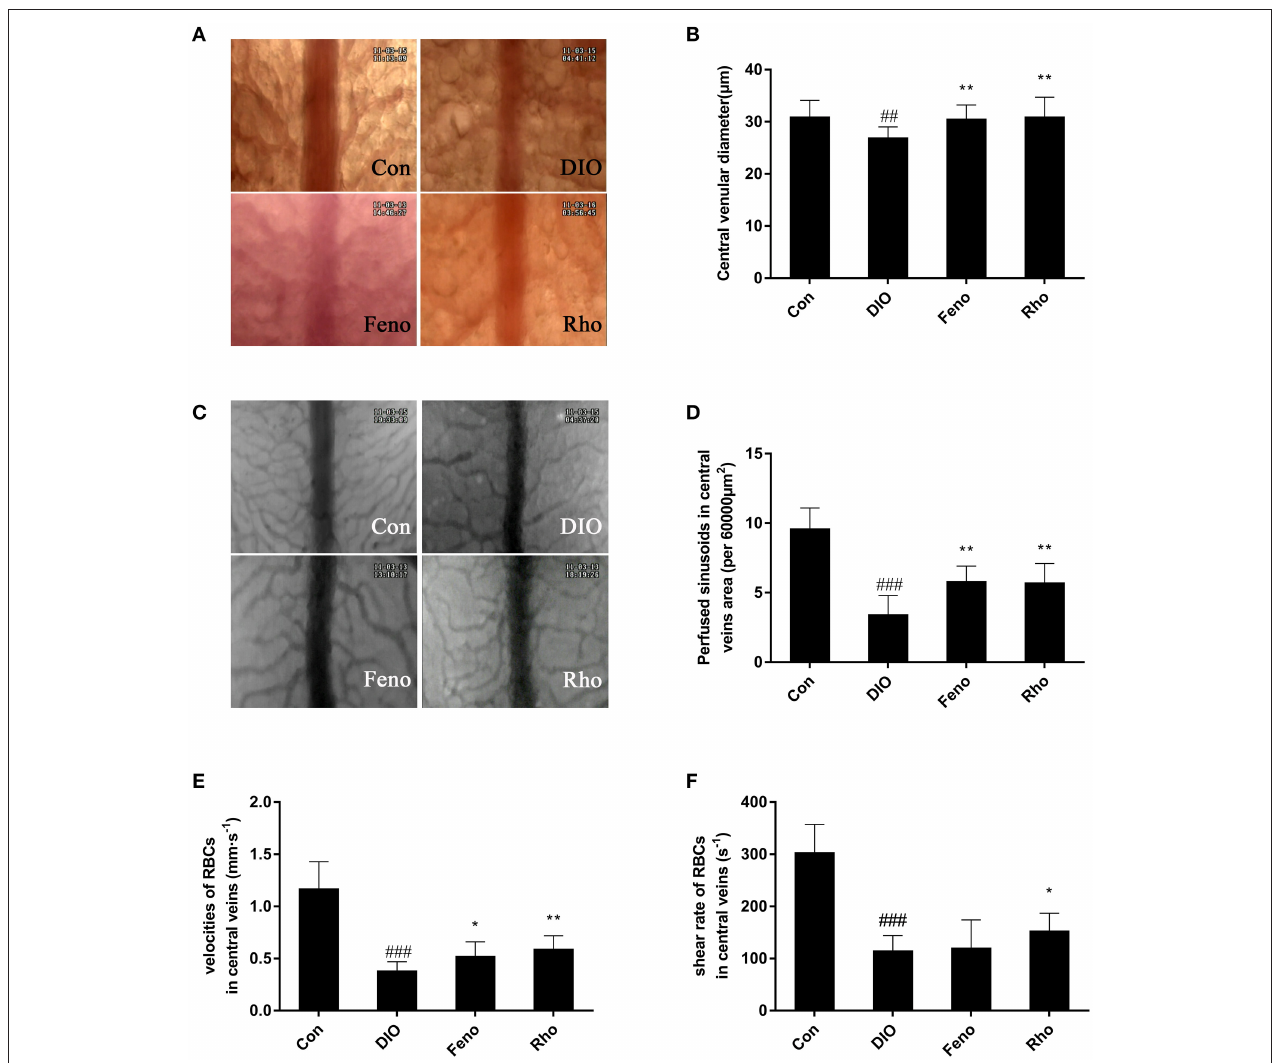
FIGURE 4 | Effects of Rho on hepatic microcirculation disturbances in DIO mice. (A) Representative images of central venular diameter ( × 200). (B) Central venular diameter. (C) Representative images of sinusoids of central veins area ( × 200). (D) Perfused sinusoids in the central veins area (per field). (E) The velocity of RBCs in central veins. (F) Shear rates of RBCs in central veins. Data are shown as the means ± SD . ## p < 0.01, ### p < 0.001 vs. Con; * p < 0.05, ** p < 0.01 vs. DIO, n =